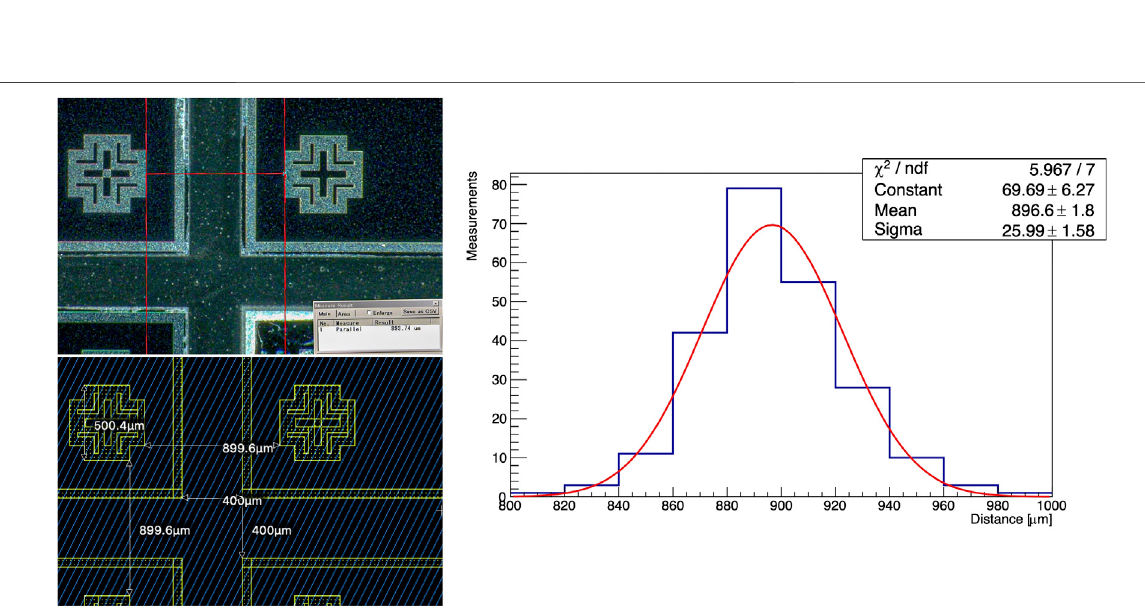
FIGURE 7 | Left: alignment crosses between chips, the design distance is 900 μ m; Right: fi t to the total distribution of the distances between crosses in WLP 2, 4 and 6.